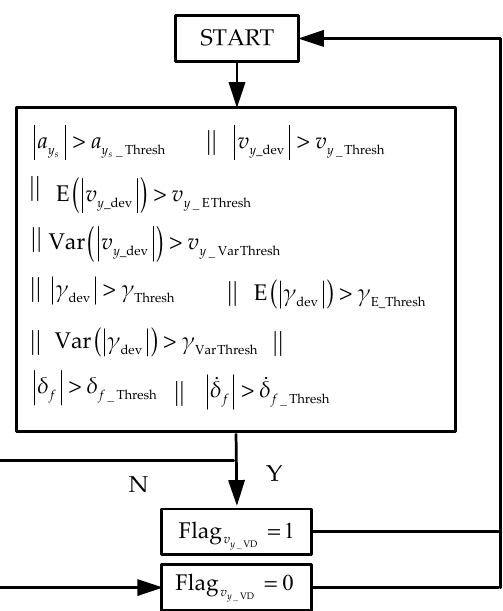
Figure 6. Feedback mechanism for lateral velocity and roll angle.